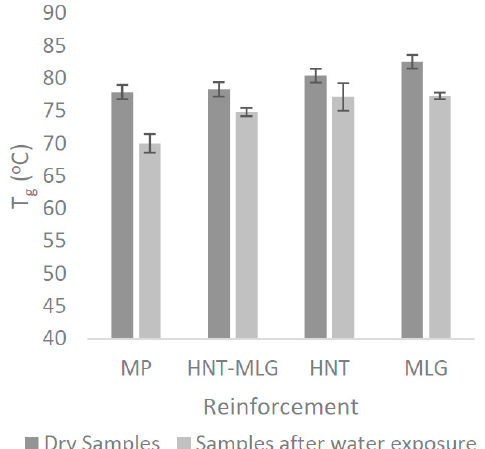
Figure 3. T g of nanocomposites in dry conditions and after water exposure.